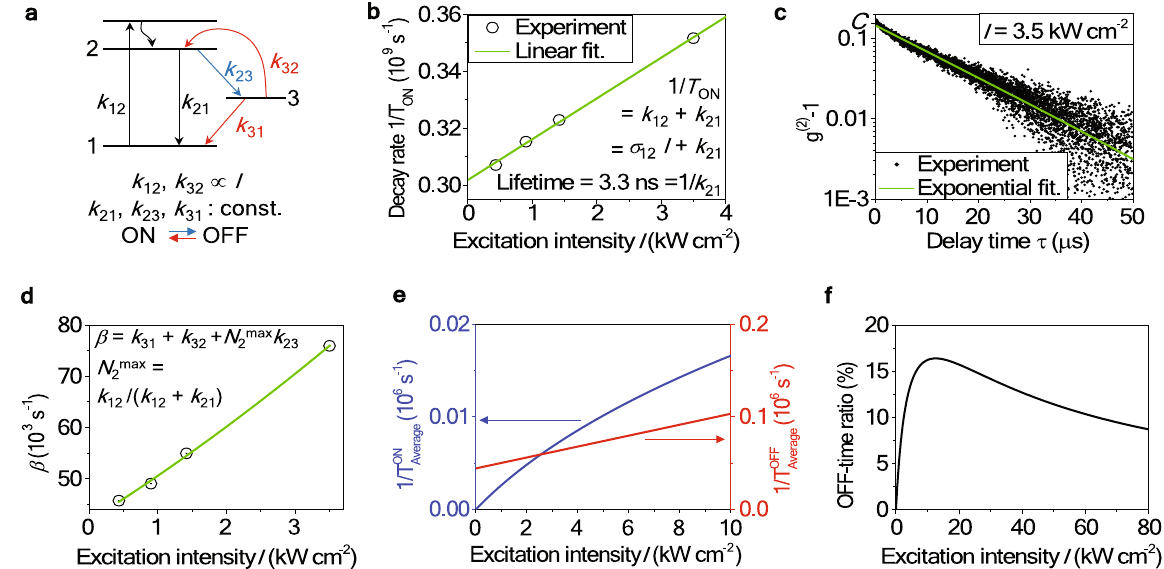
Figure 3. Blinking study by second-order correlation function g (2) ( τ ). ( a ) Energy band scheme of our target emitter. A meta-stable state of level 3 is considered for the blinking. ( b ) Decay rates 1/ T ON = k 12 + k 21 at four excitation pump intensities with a linear fitting line in green. T ON is obtained by fitting the normalized g (2) ( τ ) in short-time scale (| τ | < 100 ns) shown in Fig. 1e. ( c ) The long-time g (2) ( τ > 100 ns) is reconstructed from TTTR data obtained at an excitation intensity of 3.5 kW/cm 2 . (g (2) ( τ ) − 1) values as a function of the time delay τ is plotted in a semi-log scale and fitted with a single decaying exponential (green line) curve of τ − = βτ − g e ( ) 1 C 2 . The decay rates β at four excitation intensities are plotted in ( d ) with a function of β ≈ + + k k N k max . ( e ) The transition rates of ON → OFF ( = = T N k 1/ AverageON ) and OFF → ON 31 32 2 23 2 23 ) as a function of the excitation intensity. ( f ) The percentage ratio of the OFF time ( = = + T k k 1/ AverageOFF 31 32 duration as a function of the excitation intensity under a continuous